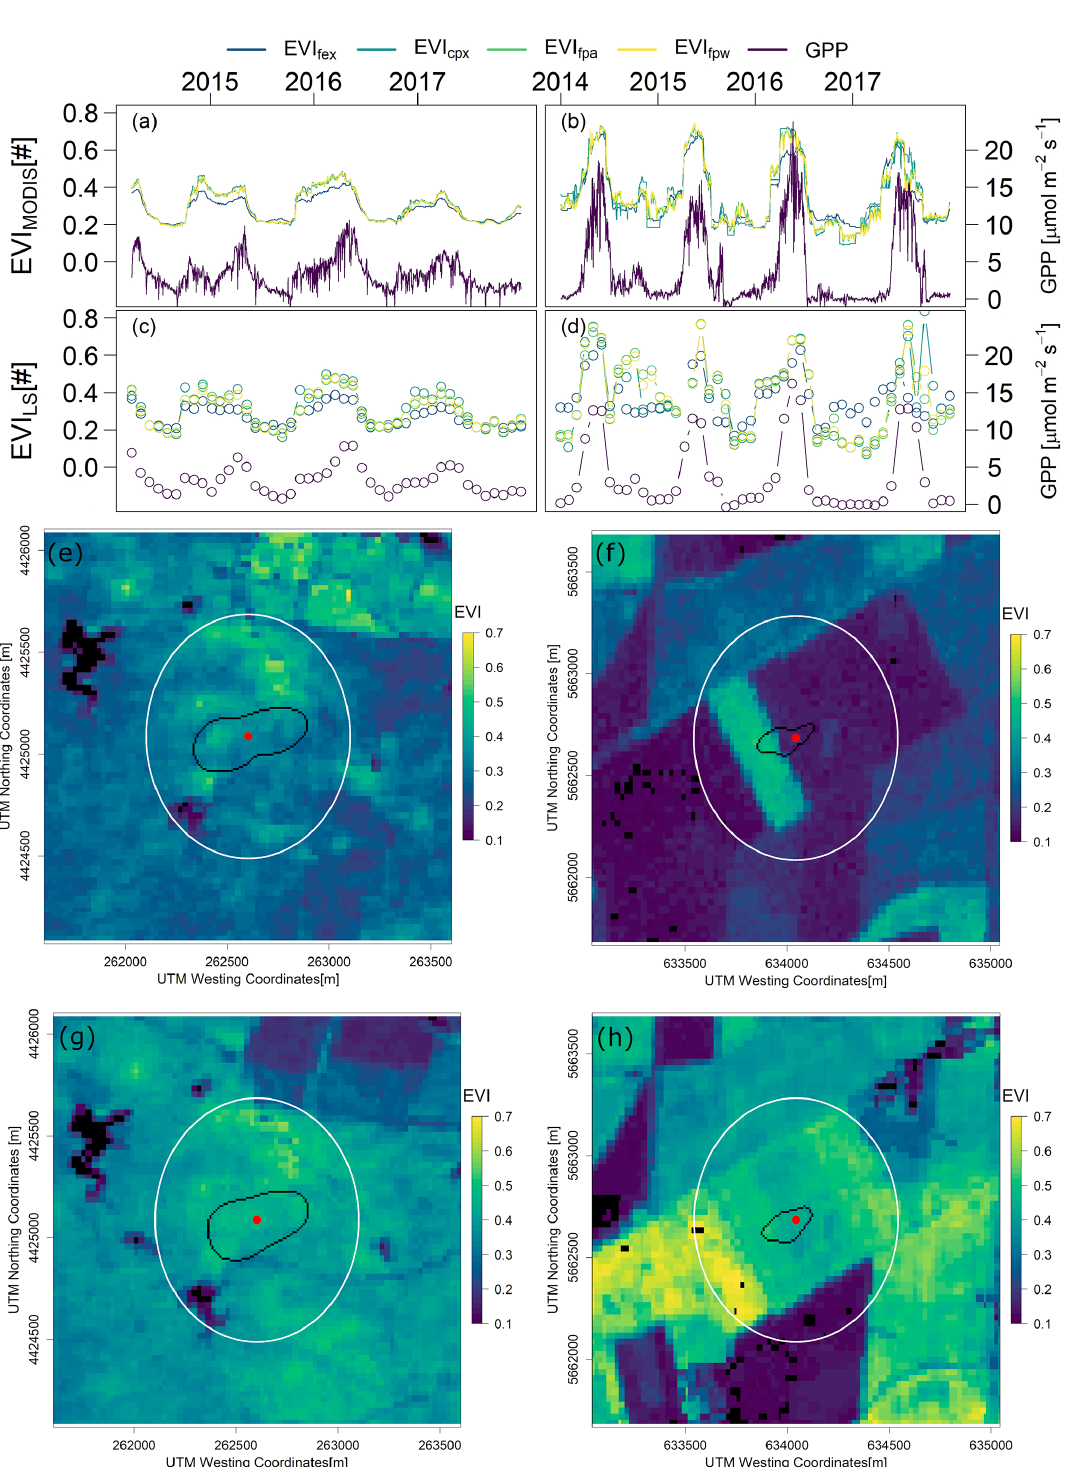
Figure 9. Time series of EVI and GPP for ES-LM1 (a, c) and DE-Geb (b, d) . MODIS EVI (a, b) and Landsat EVI (c, d) represent areas with different extents: full extent of the cutout (EVI fex ), the centre pixel that contains a tower (EVI cpx ), the EVI averaged over the flux footprint area (EVI fpa ), and the EVI fpa weighted with the flux probability density function (EVI fpw ). Panels (e) – (h) : Landsat EVI overlaid with the monthly flux footprint (black line) for ES-LM1 in November 2014 (e) and April 2016 (g) and for DE-Geb in February 2012 (f) and February 2016 (h) . Non-original low-quality EVI values are blacked out. Red circles indicate the location of the EC station, and the white circle denotes 1km diameter from the